Question: Which kind of chart has been used to present this data?
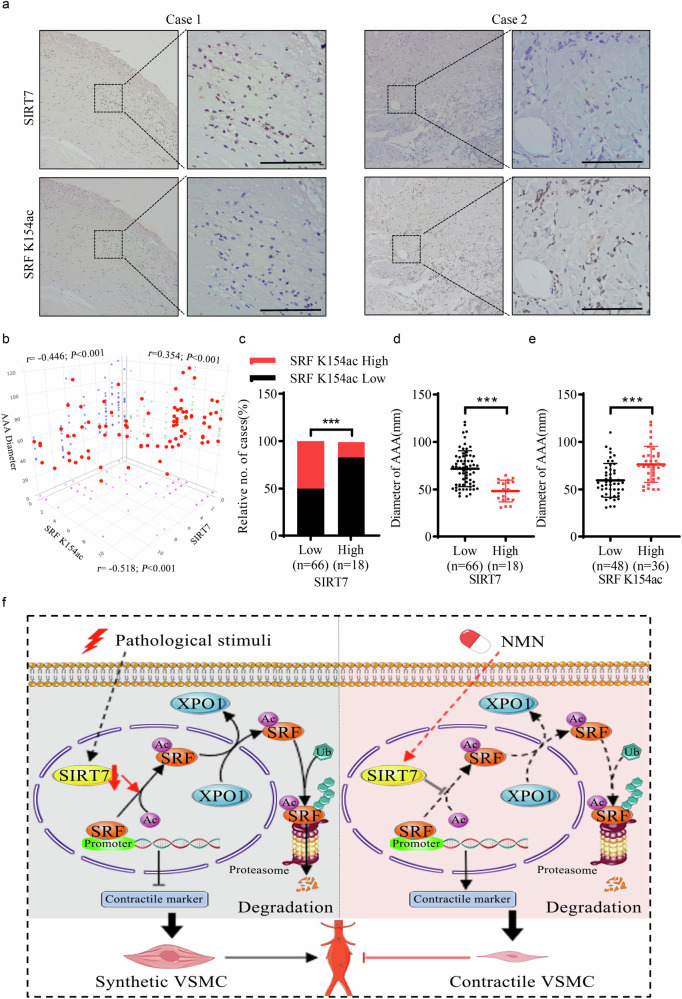
Answer: scatter